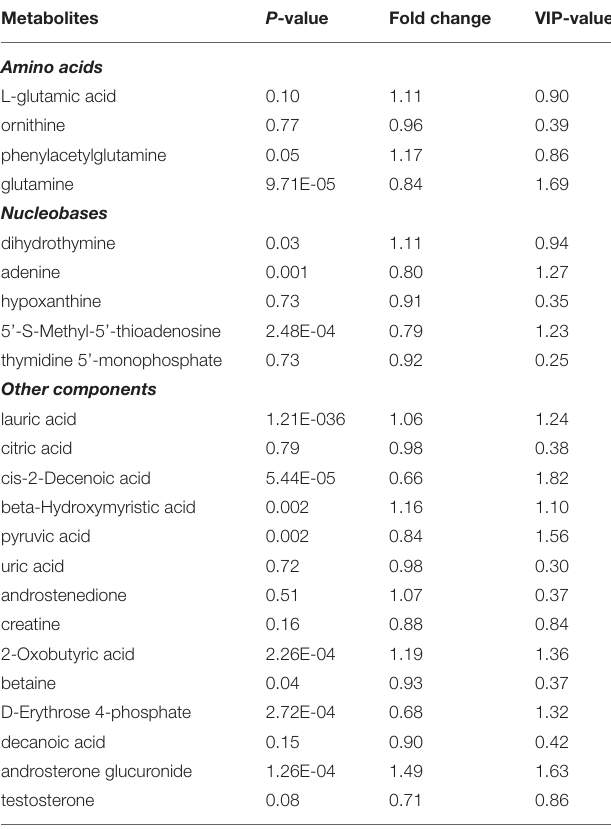
TABLE 3 | Differential metabolites hit in differential